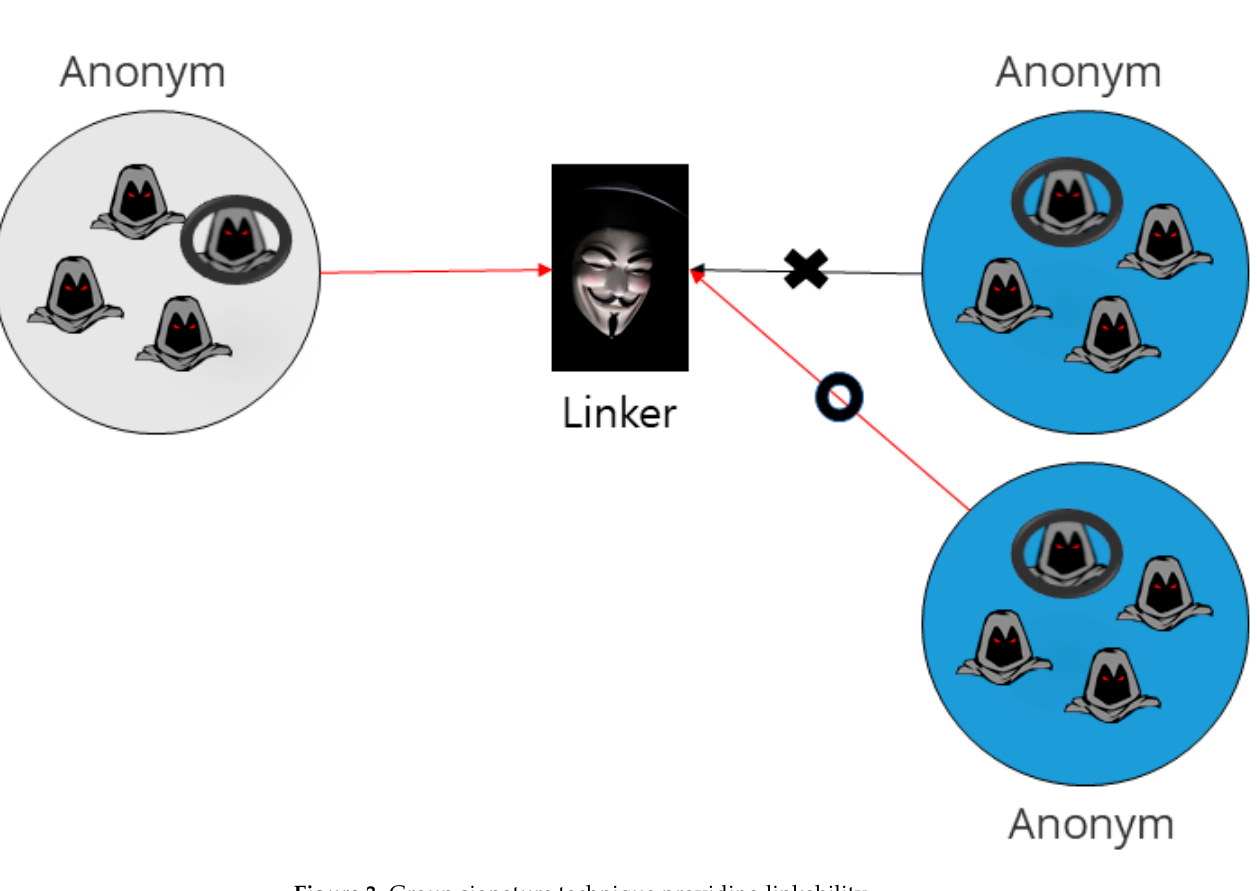
Figure 3. Group signature technique providing linkability.